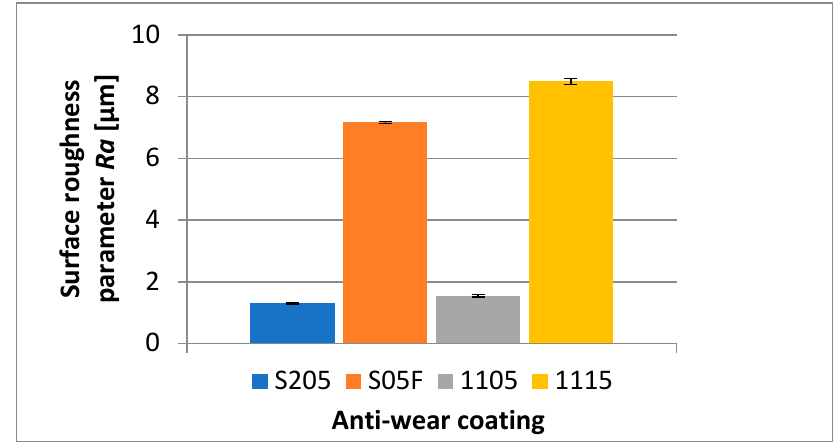
Figure 5. The influence of the cutting insert coating on the average value of the surface roughness parameter, Ra , of the machined surface.